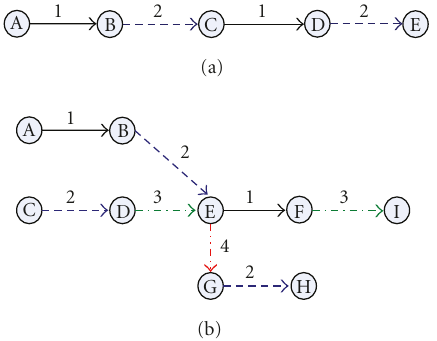
Figure 1: Channel allocation (indicated by numerical numbers) in multihop networks, an